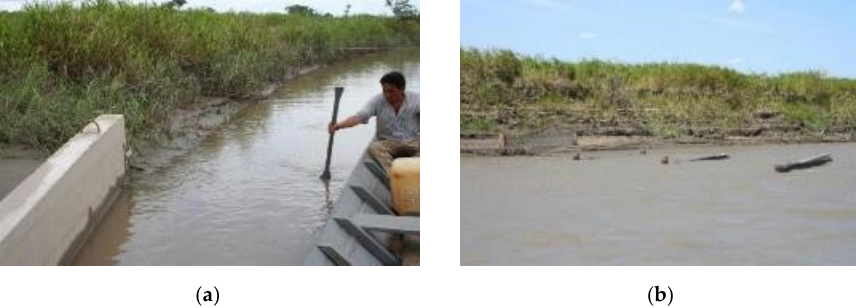
Figure 15. Metica River, Puerto López. ( a ) The sedimentation around the first panels of one of the sets generated bed depths of approximately 0.50 m, 15 days after installation. ( b ) Sedimentation progression as a result of submerged panels in January 2008 (Source: Hidroconsulta, 2007).